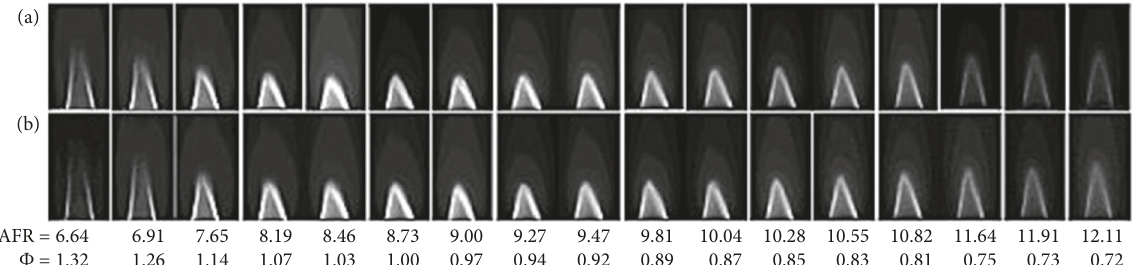
Figure 6: Images of the Saudi LPG/air flames for different air-fuel ratios (AFR): (a) at fixed 0.72 of the Saudi LPG flow rate and (b) at fixed 0.76l/min of the Saudi LPG flow rate, mixing in the mixing tube using the modified Bunsen burner.